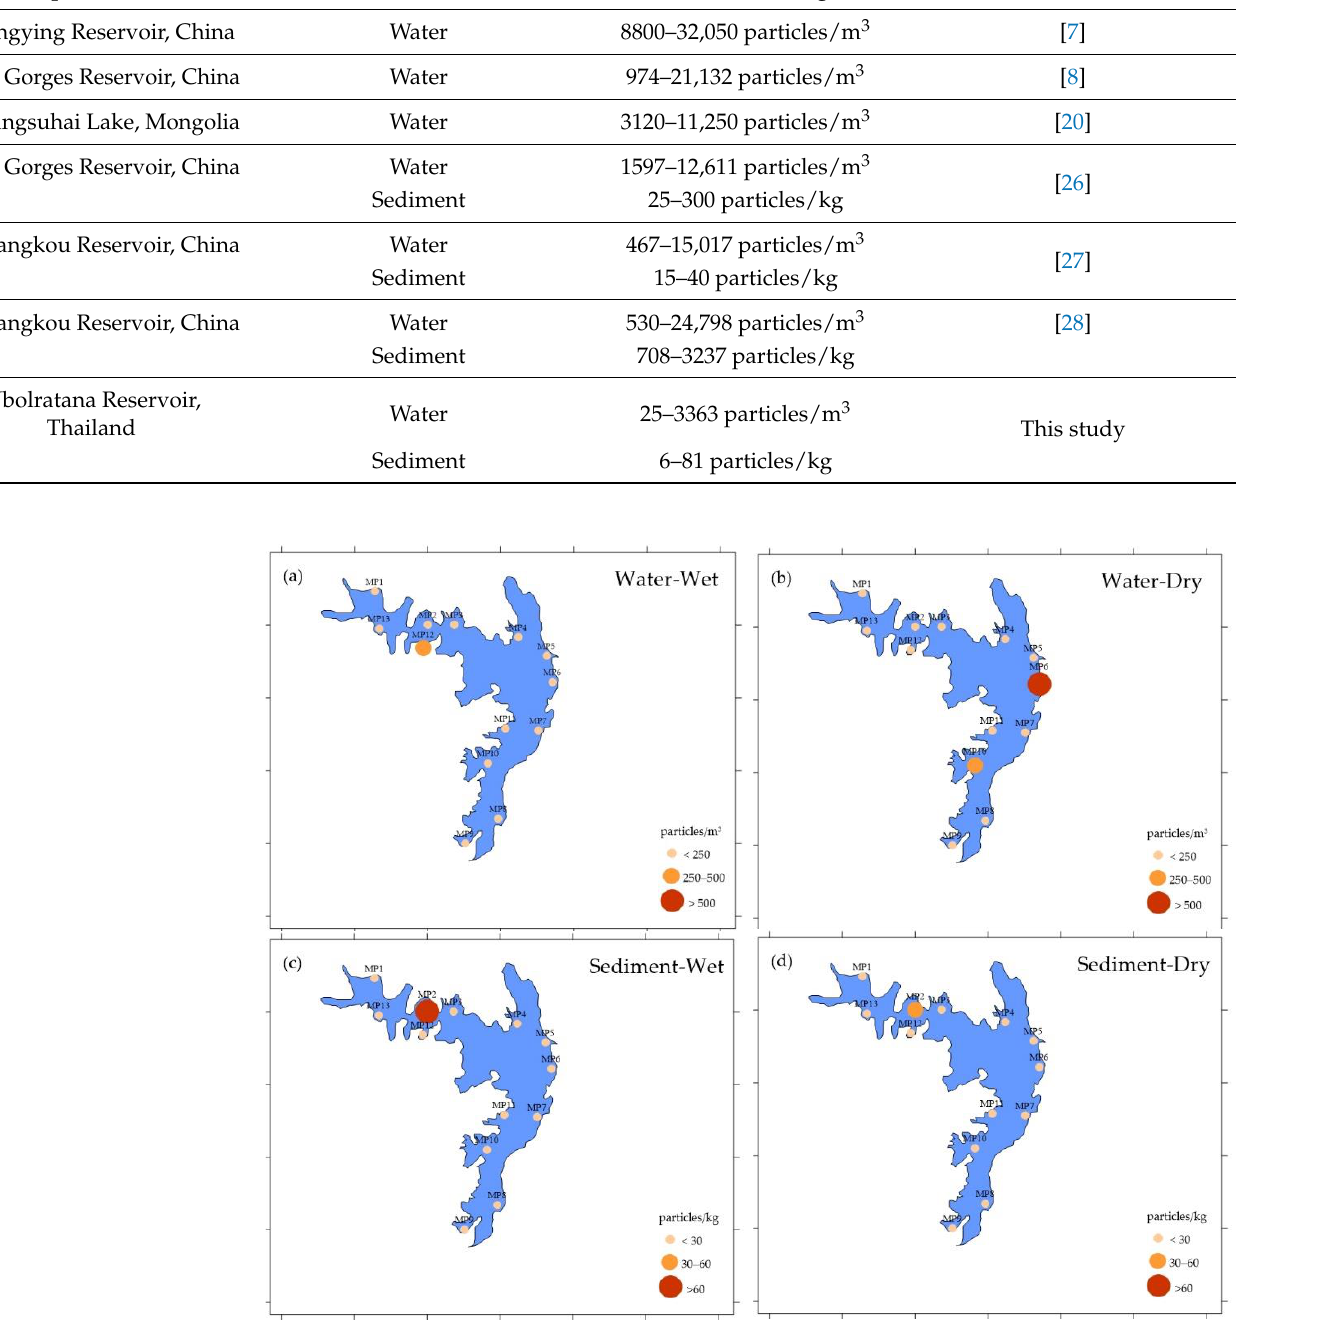
Figure 2. Spatial distribution of microplastics in ( a ) surface water (particles/m 3 ) during the wet season, ( b ) dry season, and in ( c ) sediment (particles/kg) during the wet season, and ( d ) dry season, of the Ubolratana Reservoir.